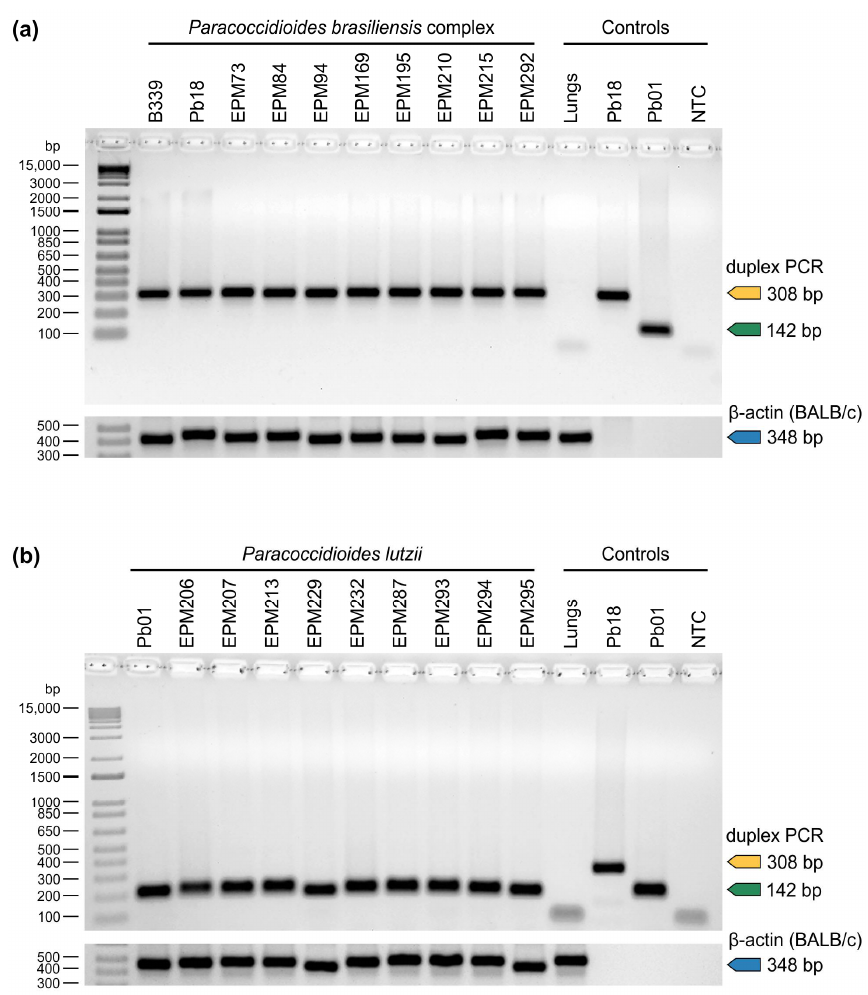
Figure 5. The potential use of our duplex PCR assay for detection studies. Agarose gel electrophoresis showing successful detection of Paracoccidioides DNA from spiked BALB/c lungs, using a duplex PCR assay. ( a ) BALB/c lungs spiked with Paracoccidioides brasiliensis yeasts (1 × 10 5 yeasts). ( b ) BALB/c lungs spiked with Paracoccidioides lutzii yeasts (1 × 10 5 yeasts). Controls include BALB/c lungs not spiked with Paracoccidioides ; Pb18: P. brasiliensis complex positive control; Pb01: P. lutzii positive control; NTC: no template control. Lower panels represent the DNA quality control for BALB/c assessed by amplifying the β -actin gene. A positive β -actin amplification (348 bp) confirmed that the samples were free of PCR inhibitors. Data are representative of two independent experiments.